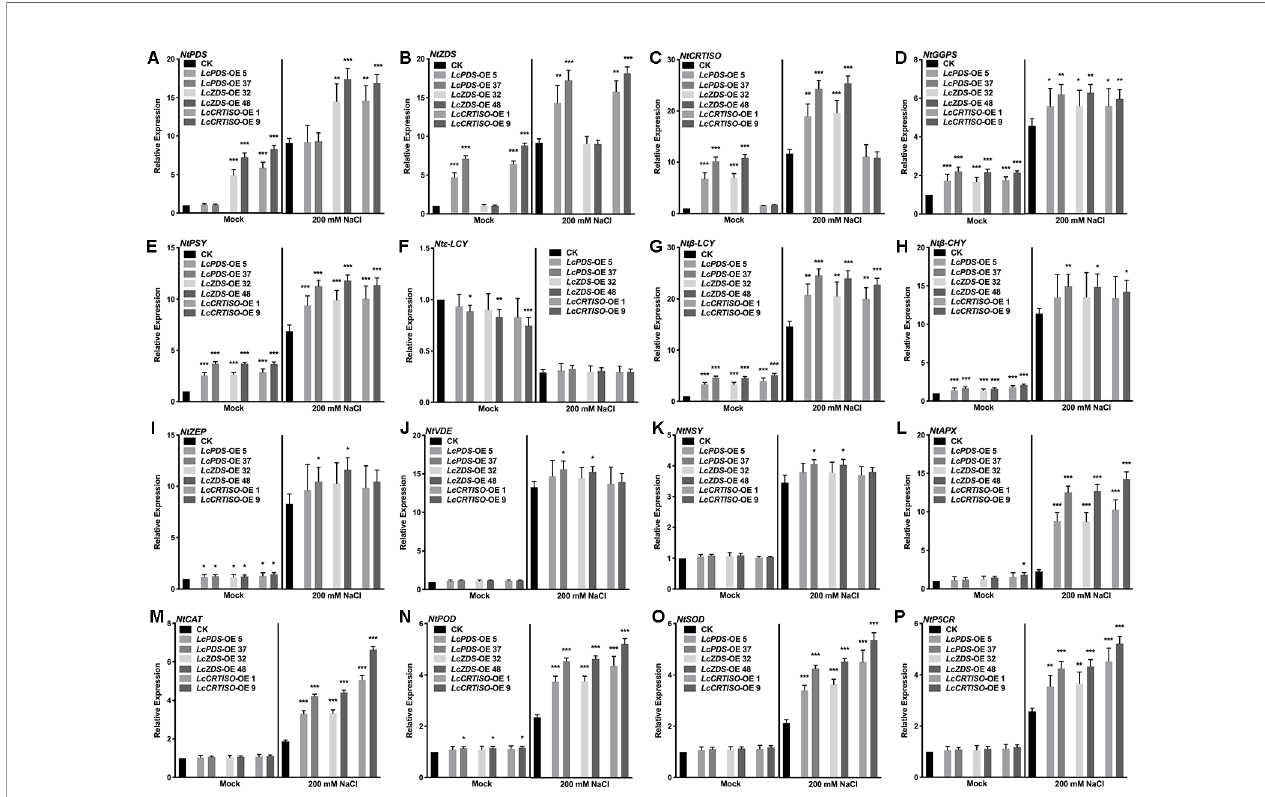
FIGURE 6 | Expression analysis of genes involved in the carotenoid biosynthesis and the salt stress-response in LcPDS , LcZDS , and LcCRTISO over-expressing tobacco lines under salt stress. Gene expression level of (A) NtPDS , (B) NtZDS , (C) NtCRTISO , (D) NtGGPS , (E) NtPSY , (F) Nt ϵ - LCY , (G) Nt b -LCY , (H) Nt b - CHY , (I) NtZEP , (J) NtVDE , (K) NtNSY , (L) NtAPX , (M) NtCAT , (N) NtPOD , (O) NtSOD , and (P) NtP5CR were measured by quantitative real-time (qRT)-PCR, and NtActin was set as control. Data were obtained from three independent experiments and ANOVAs was performed. The results were presented as means ± SD. P values of < 0.05 (*), < 0.01 (**), and < 0.001 (***) were considered to be signi fi cant